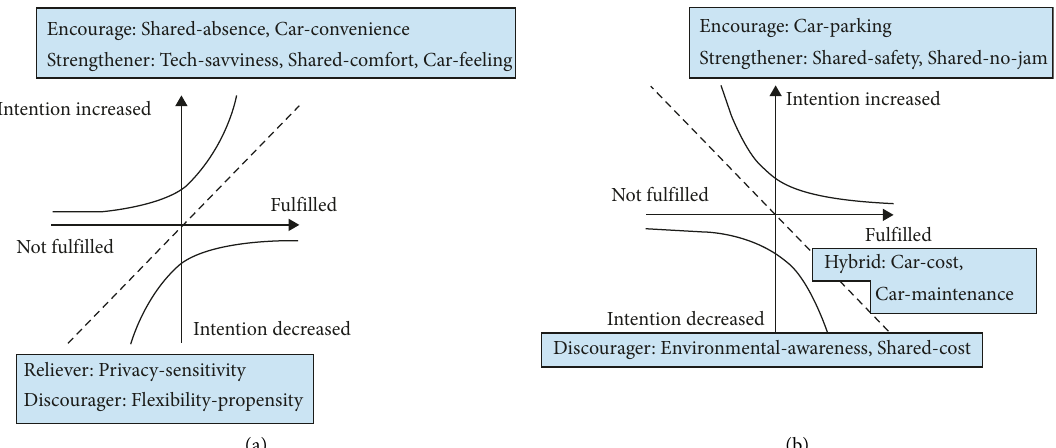
Figure 6: The asymmetric factor structure of the post-COVID-19 intention change. (a) Positive correlations. (b) Negative